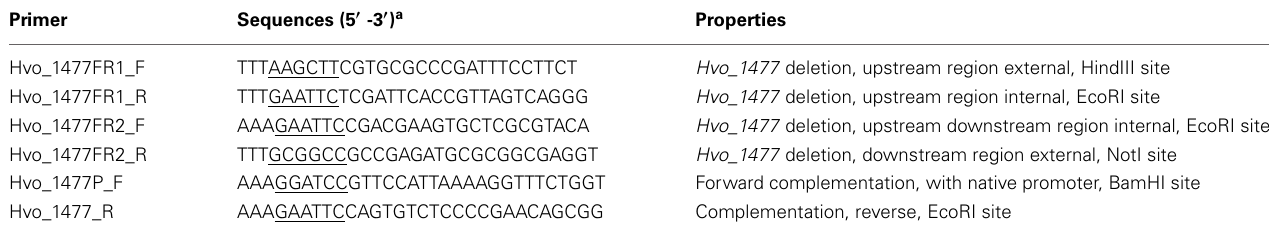
Table 3 | Oligonucleotide primers